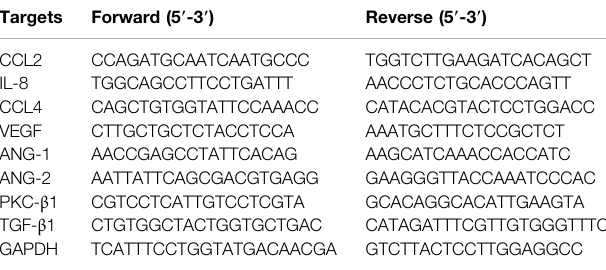
TABLE 1 | The primer sequences used for